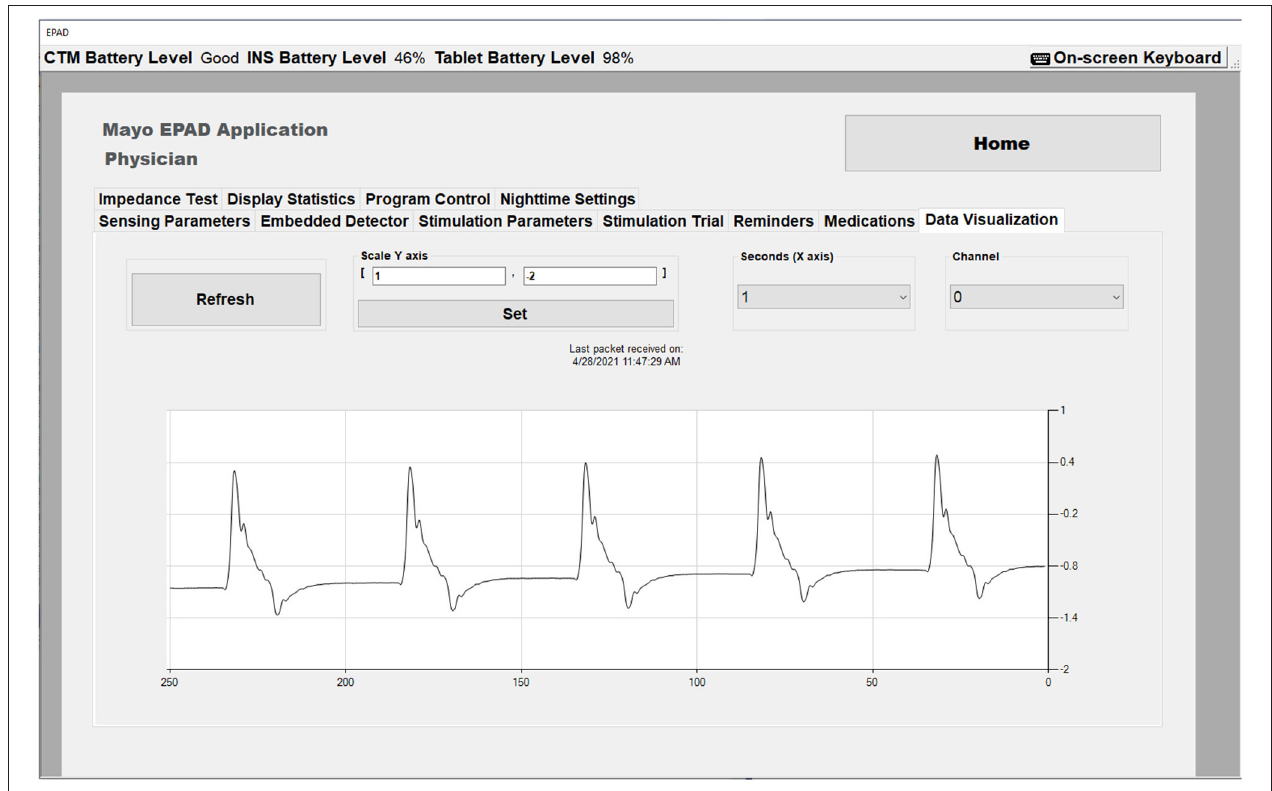
FIGURE 3 | The EPAD Data Visualization tab in Physician mode showing real time data with stimulation artifact (Amplitude = 2mA, Rate =